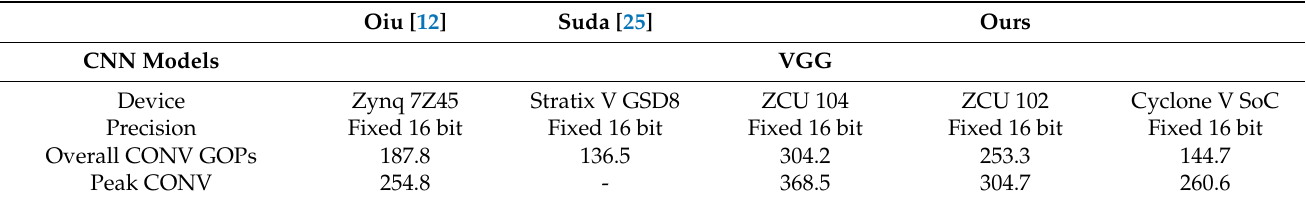
Table 4. Comparison with other FPGA work.